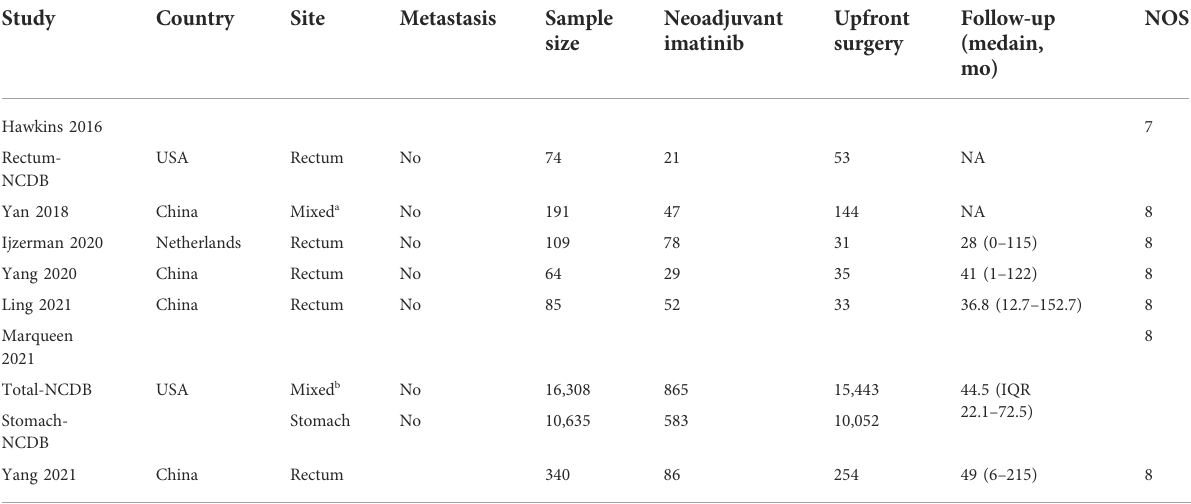
TABLE 1 Summarization of the seven included